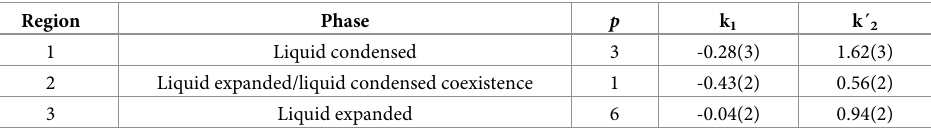
Table 1. Fitting parameters of π /A curves of Fig 5 for different regions of monolayer